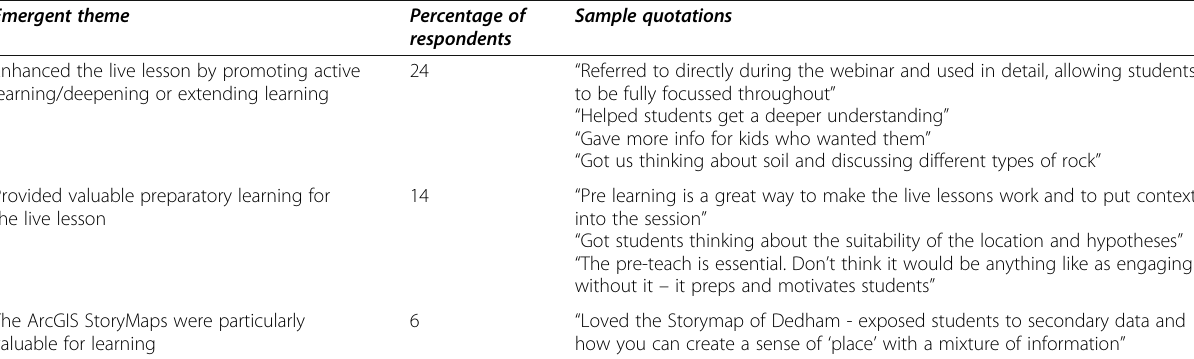
Table 4 Emergent themes in the content analysis for response data to the question: “ What did you like about the resource packs? ” ( n = 188). Only themes with > 5% respondents are